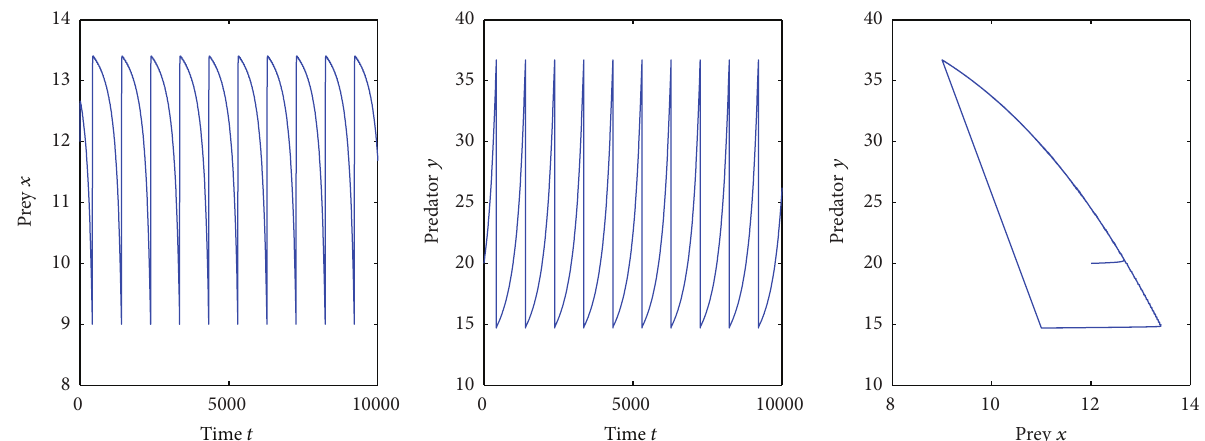
Figure 10: Time series and portrait phase of the system (2) when 𝑟 = 0.5 , 𝐾 = 15 , 𝑎 = 100 , 𝜇 = 0.8 , 𝐷 = 0.038 , ℎ = 9 , 𝜏 = 2 , 𝛽 = 0.6 , and (𝑥(0),𝑦(0)) = (12, 20) .